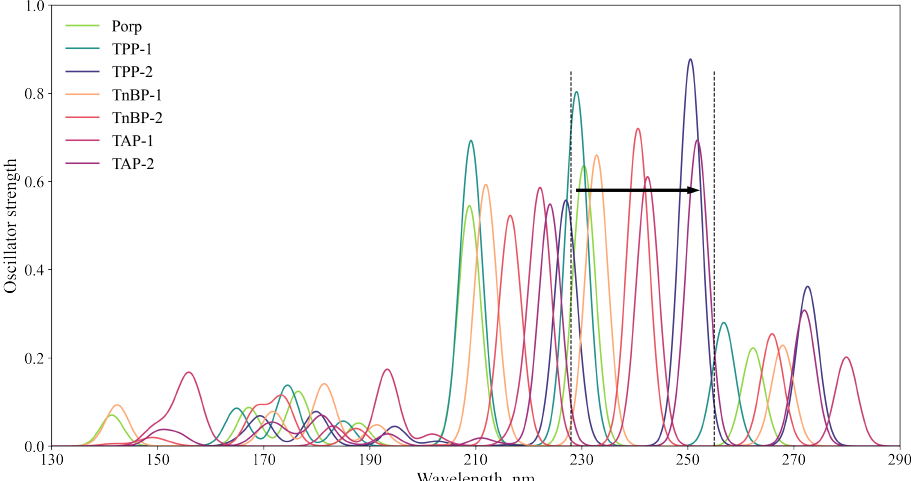
Figure 4. Excitation spectra of porphine derivatives obtained by TD-HF (HF-3c level of theory, full width at half maximum (FWHM) = 5 nm). The arrow shows the shift of the main excitation on the red side from TPP-1 to TAP-2 and the dashed lines separate the three main excitations, which are typical for